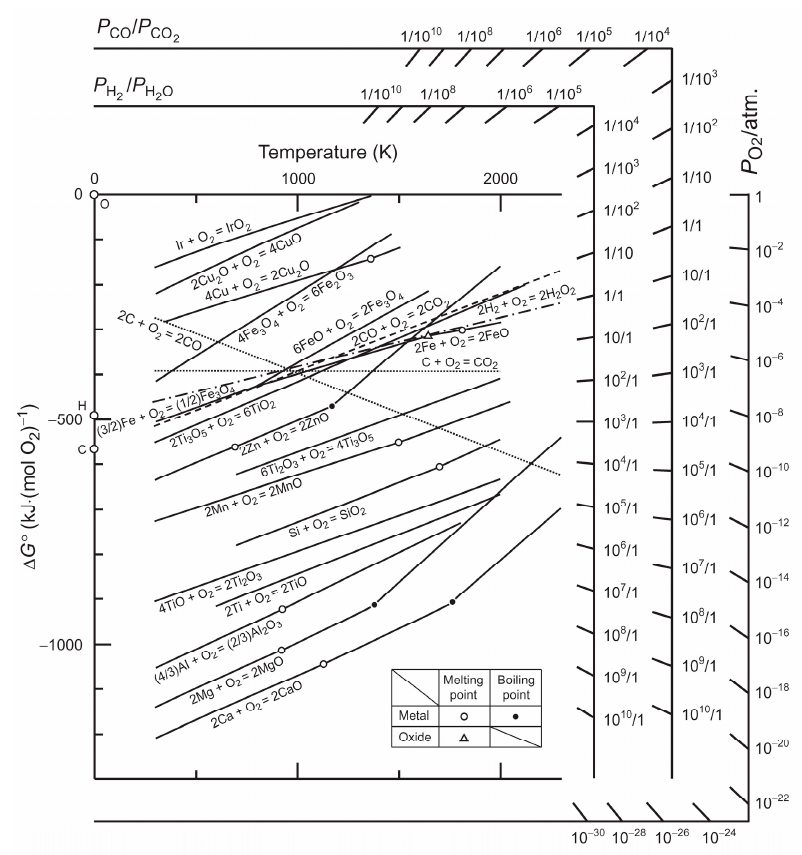
Figure 15. Elligham diagram of some oxides (reprinted from Treatise on Process Metallurgy, Volume 1, Masakatsu Hasegawa, Ellingham Diagram, 10, Copyright 2022, with permission from